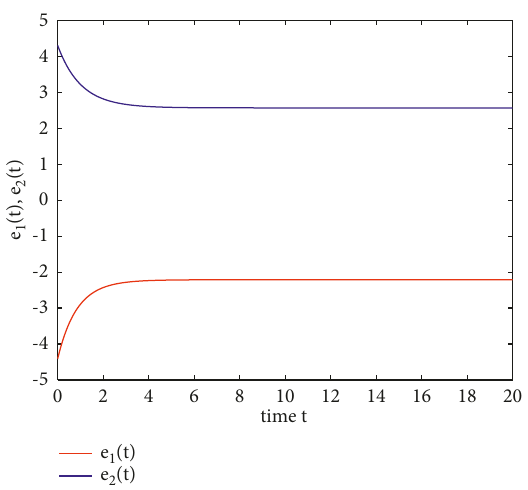
Figure 9: (a) Trajectories of x response system without controller.